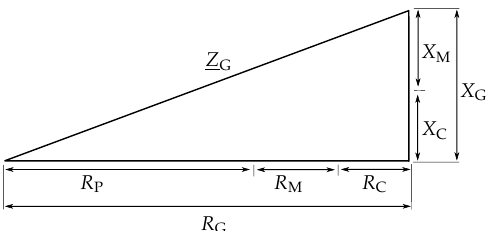
Figure 17. A grounding system’s impedance triangle, based on Reference